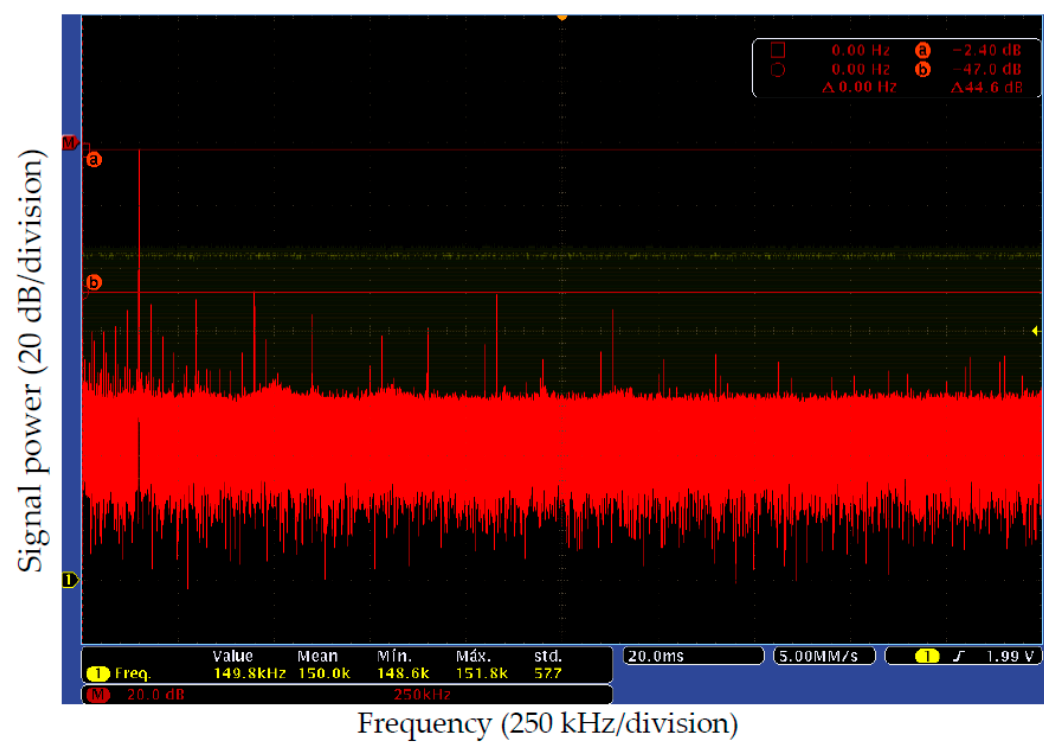
Figure 10. Spectrum (signal power in dB versus frequency) of the generated sine signal at 150 kHz frequency.